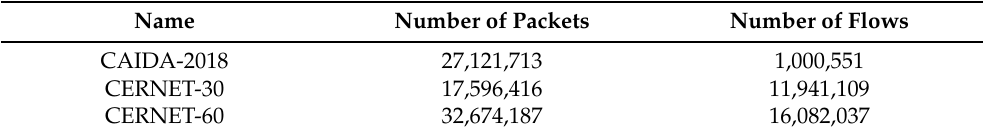
Table 2. Information about the experimental datasets.